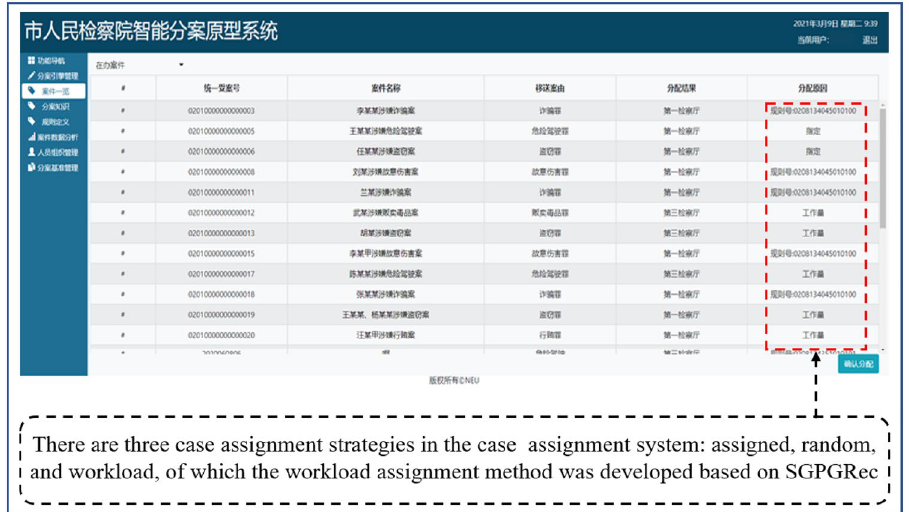
Figure 11. Visualization of pre-training generative tasks